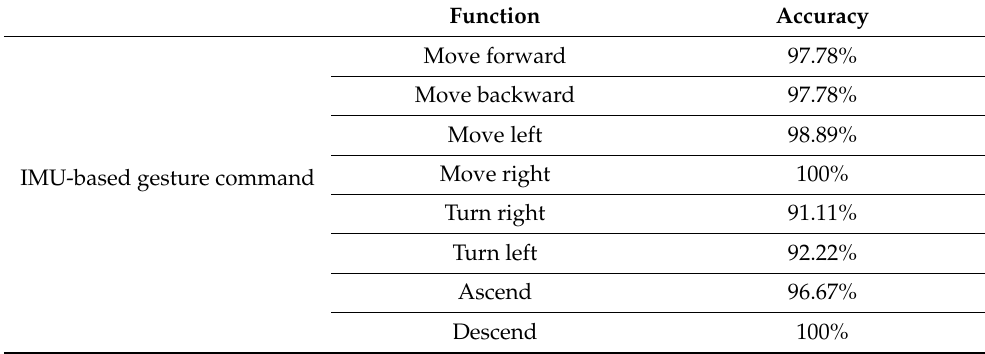
Table 4. Result of evaluating the utility of each function for each dynamic gesture.